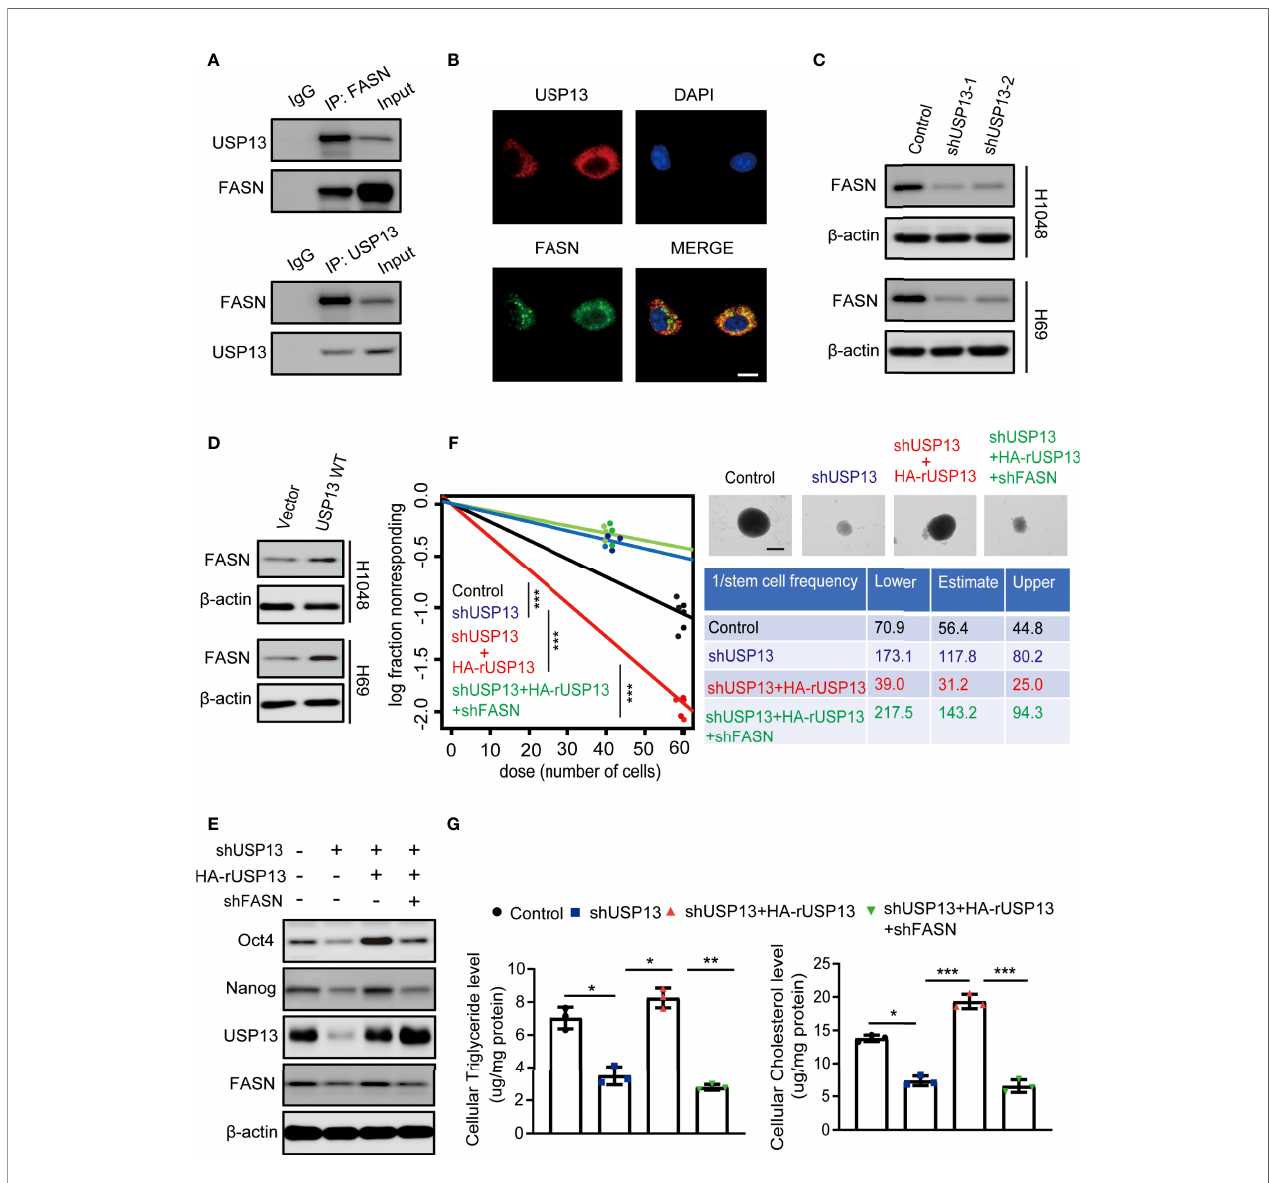
FIGURE 3 | USP13-dependent FASN expression promotes SCLC stemness and lipogenesis. (A) Immunoprecipitation and immunoblot analyses were performed with the indicated antibodies in H1048 cells. (B) Immuno fl uorescence analyses were performed with the indicated antibodies in H1048 cells. DAPI was used for nuclear staining. Scale bars: 20 m m. (C, D) FASN expression levels were detected in H1048 (top) or H69 (bottom) cells with or without USP13 depletion (C) or overexpression (D) by immunoblot analyses with an anti-FASN antibody. (E) H1048 cells with or without USP13 shRNA expression, or USP13 depletion reconstituted expression of WT HA-rUSP13 with or without FASN depletion were analyzed by immunoblotting with the indicated antibodies. (F) Left: ELDA was performed in H1048 cells with or without USP13 shRNA expression, or USP13 depletion combined with reconstituted expression of WT HA-rUSP13 with or without FASN depletion. Representative sphere images (top right) and stemness frequency illustration of the cells with the upper and lower 95% con fi dence intervals (bottom right) are shown. Scale bars, 50 m m. Data represent the means ± SD of wells. Two-tailed student ’ s t-test was used. *** p < 0.001. (G) Cellular triglyceride levels (left) and cholesterol levels (right) in H1048 cells with or without USP13 shRNA expression, or USP13 depletion combined expression of reconstituted expression of WT HA-rUSP13 with or without FASN depletion were determined. Data shown are the mean ± S.D. ( n =3). Two-tailed student ’ s t-test was used. * p < 0.05, ** p < 0.01, *** p <